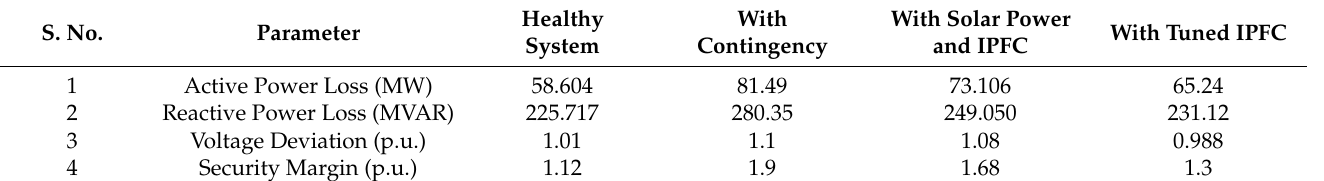
Table 7. The voltage profile of the IEEE ‐ 57 bus system with and without optimum IPFC and PV unit is shown in Figure 13. The voltage profile of the system is improved and smoothened in the presence of IPFC and the solar unit. Table 6. Comparison of System Parameters for an IEEE 57 Bus system. Table 6. Comparison of System Parameters for an IEEE 57 Bus system.